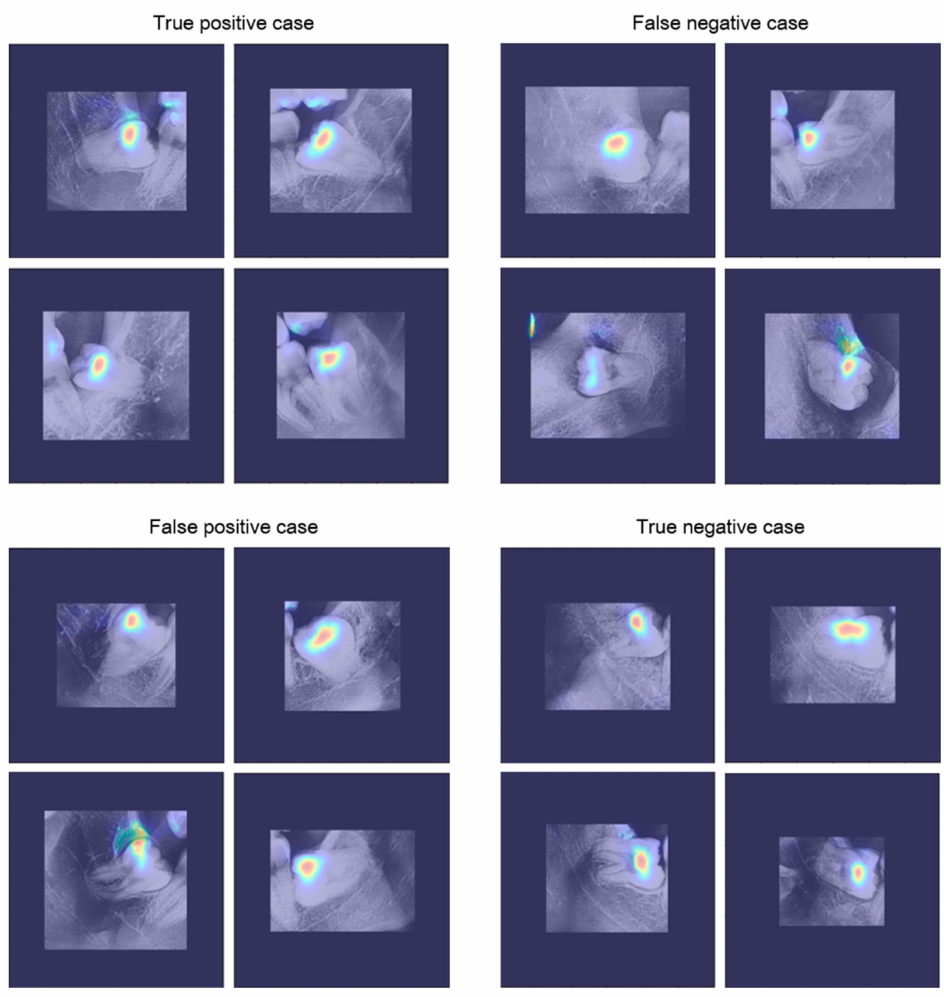
Figure 7. CNN visualization